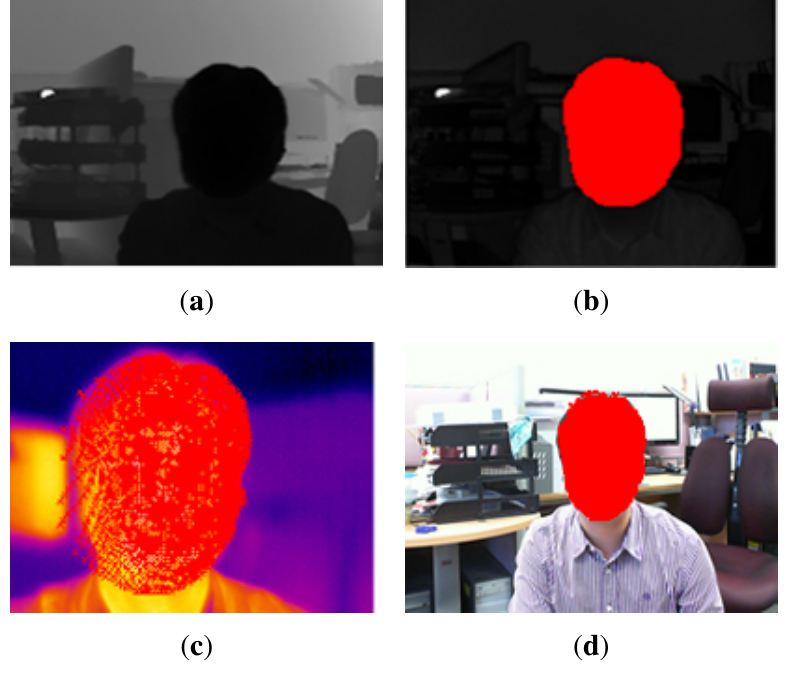
Figure 9. ( a ) 3D depth image and corresponding points in the near-IR image ( b ); thermal-IR image ( c ); and visible (color) image ( d